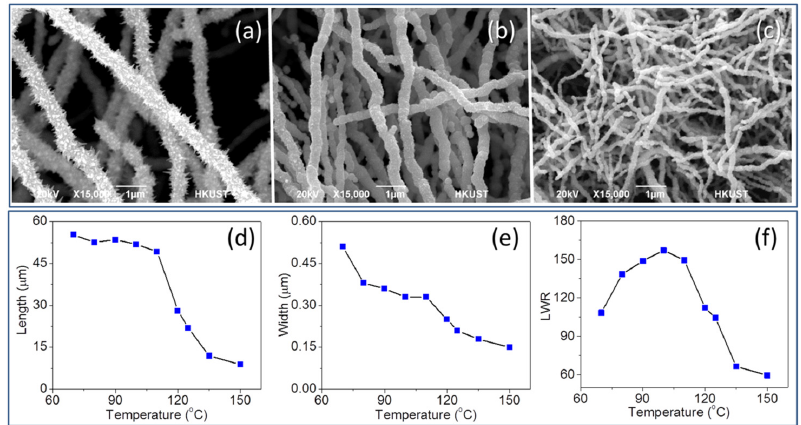
Figure 2. SEM images with same magnification of NiNWs synthesized at ( a ) 70 °C, ( b ) 110 °C, and ( c ) 150 °C. The change of ( d ) length, ( e ) width, and ( f ) length-to-width ratio (LWR) of NiNWs with temperature.